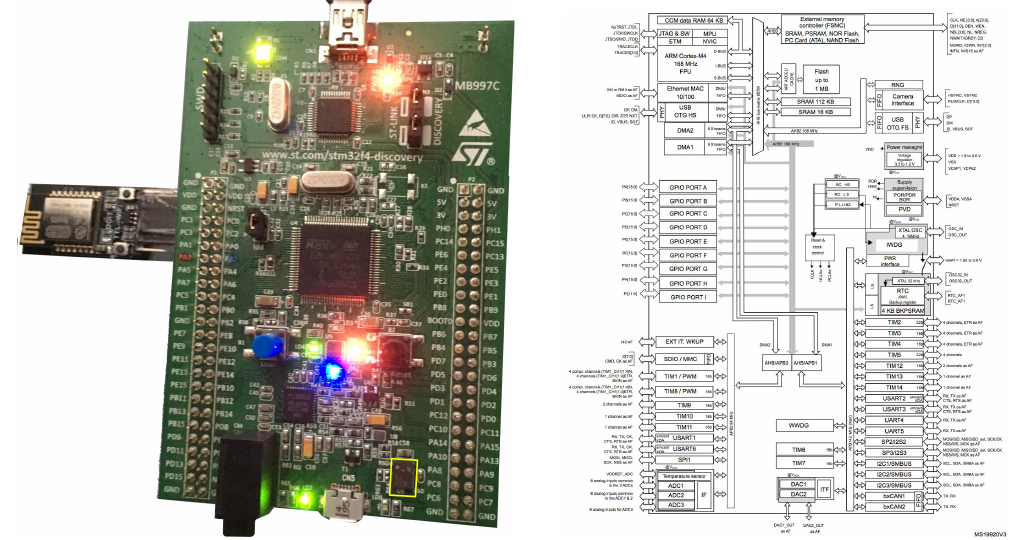
Figure 8. STM32F4Discovery board with MP45DT02 and STM32F407VG SoC overview.